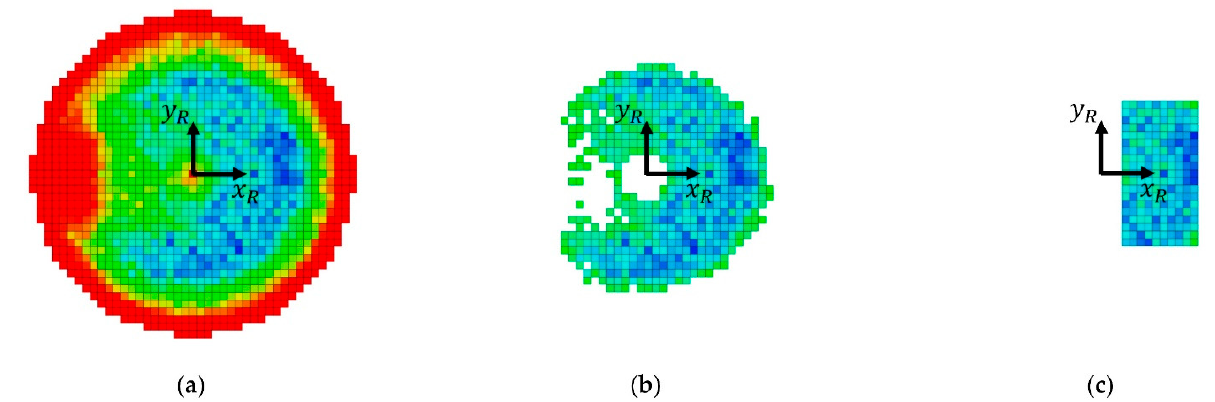
Figure 14. Workspace analysis of the manipulator for the inspection task at the corresponding height. ( a ) Cut through the x,y-plane; ( b ) Cut through the x,y-plane with reachability threshold of 50%; ( c ) chosen workspace area at height z r = 0.1 m.